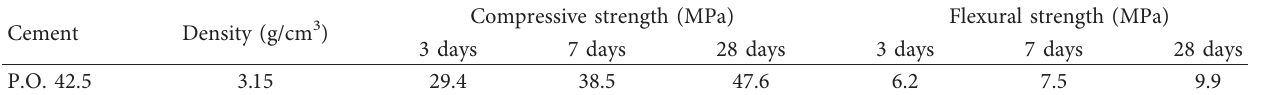
Table 2: Cement basic index.